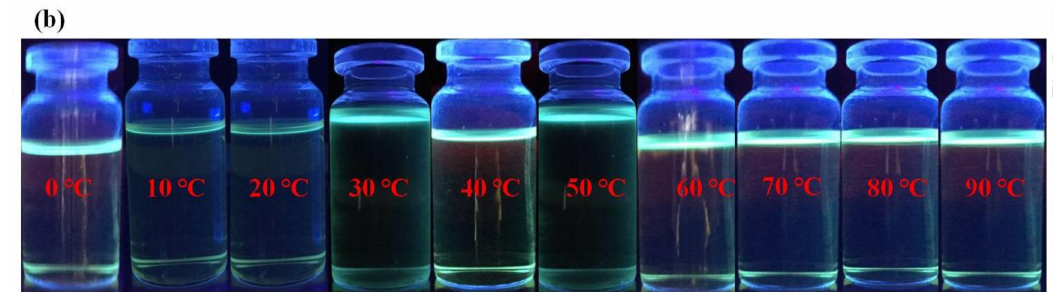
Figure 9. ( a ) Fluorescence intensity changes of the solution contain sensor H 4 L and 3.0 equiv. Cd 2+ with the delay of time; ( b ) Fluorescent intensity changes of the solution contain H 4 L and 3.0 equiv. Cd 2+ at different temperatures.